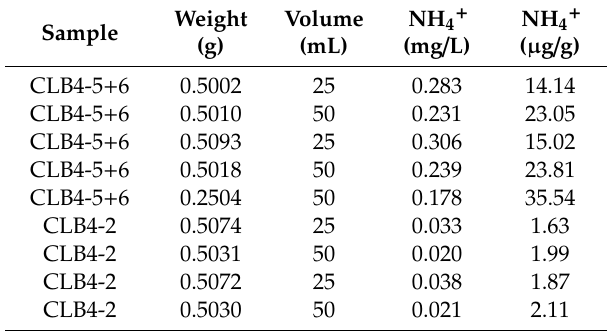
Table 3. Concentration of NH 4 + in sample CLB4-5 + 6 (a mixture of sample CLB4-5 and CLB4-6) and CLB4-2. Weight Sample (g)